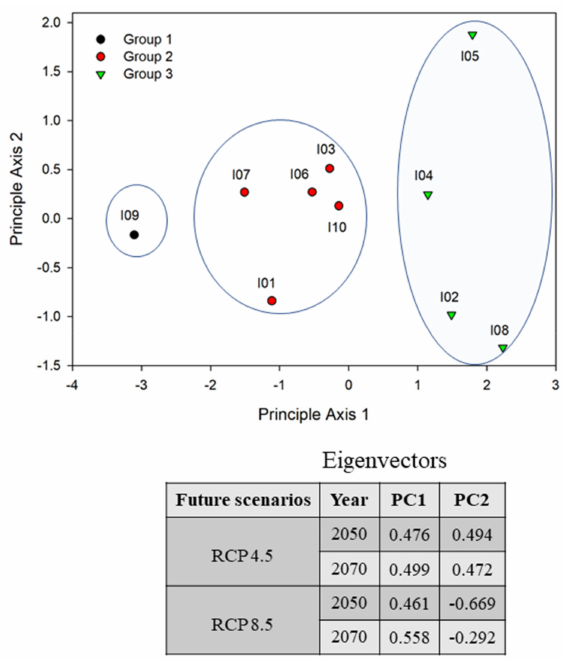
Figure 4. Principal component analysis reveals the grouping of introduced alien plant species based on the extent of their spatial distribution. The scientific and common names of the introduced alien plants (I01 − I10) are presented in Table